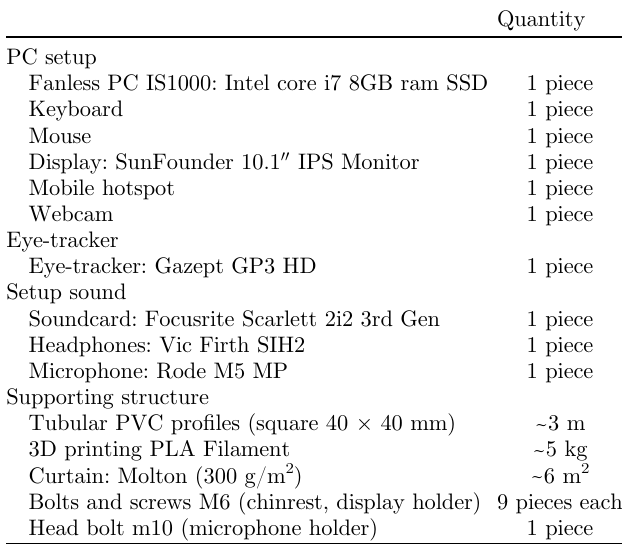
Table 1. Components that are used for the Mobile apparatus for audio-visual experiments